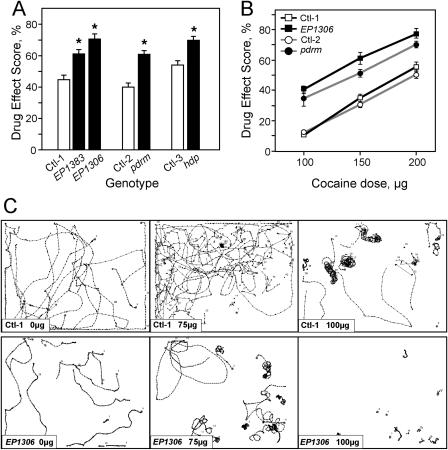

Lmo Loss-of-Function Mutants Show Increased Sensitivity to Cocaine(A) Cocaine phenotypes of various Lmo mutants. Male flies hemizygous for the indicated Lmo alleles (and their appropriate genetic controls) were exposed to 150 μg of cocaine and tested in the crackometer as described in Materials and Methods. Compared to their control (Ctl-1), EP1383 (p < 0.02) and EP1306 (p < 0.001) flies show significantly increased sensitivity to cocaine. Similarly, compared to their respective controls, pdrm and hdp flies are significantly more sensitive to cocaine (p < 0.001). Asterisks denote significant differences from controls (Student's paired t-test assuming equal variance); n = 20 experiments.(B) Cocaine dose–response. EP1306 flies (filled squares) and pdrm flies (filled circles) and their respective controls were exposed to the indicated doses of cocaine. At each dose, the responses of EP1306 and pdrm flies are significantly higher than their controls (p < 0.001, n = 16–20 experiments).(C) EP1306 flies show alterations in cocaine-induced locomotor patterns of activity. Flies were exposed to 0, 75, or 100 μg of cocaine, as indicated, for 1 min. Representative traces shown correspond to 30 s of recorded activity of about ten flies starting 1 min after the end of cocaine exposure (n ≥ 4). Top panels show response of control flies to indicated amounts of cocaine; bottom panels show activity of EP1306 flies after cocaine administration. Ctl-1 is EP1631, Ctl-2 is P[GAL4] line 8.142, and Ctl-3 is w1118.